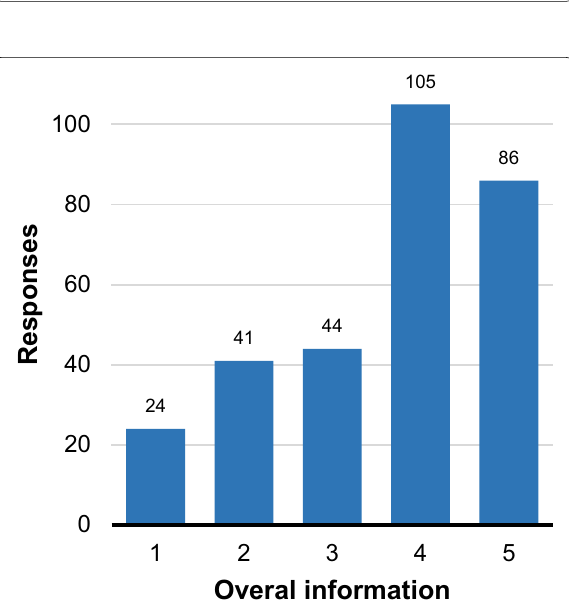
very unsatisfied, 5 very = =